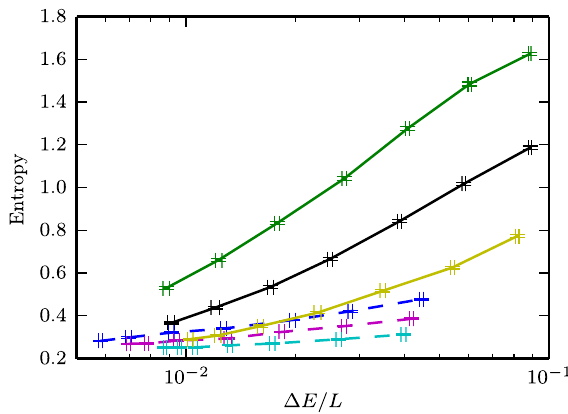
FIG. 5. The entanglement entropy at the center of the system as a function of Δ E=L for various system sizes and initial states used in the IQPE algorithm. Dashed lines show data for initial product states in the S z basis, while solid lines show data for initial states with a mix of S z and S x bases, as explained in the text. System sizes are, from top to bottom, L ¼ 12 , 10, and